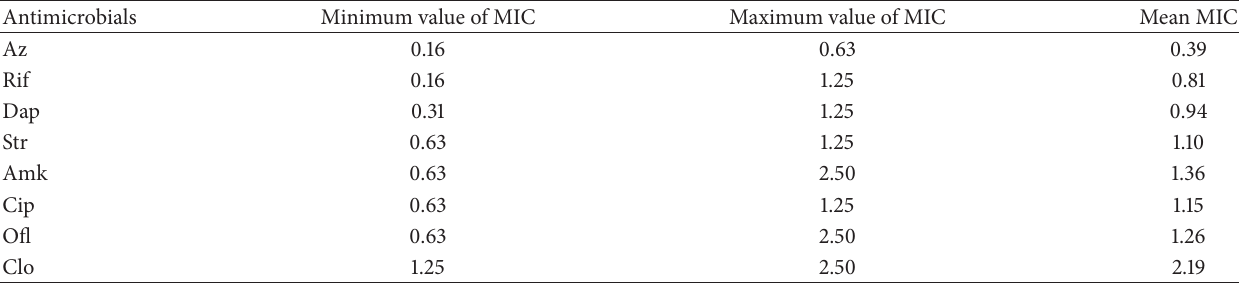
Table 2: Mean, minimum, and maximum values of MIC ( 𝜇 g/mL).